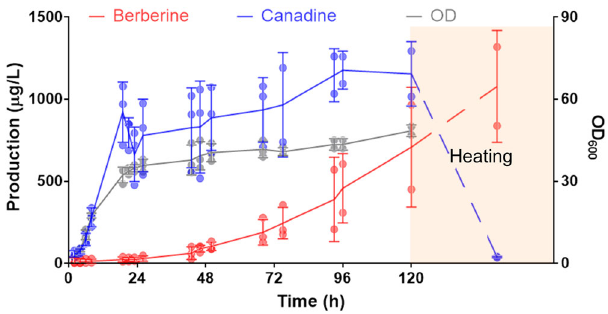
Fig. 3 Scale-up fermentation of BBR4R strain. Berberine titer, canadine titer and OD600 during the bioprocessing followed by a 36-hour heating are shown. Error bars represent either standard deviation of three independent fermentations for points before 72 h or of two